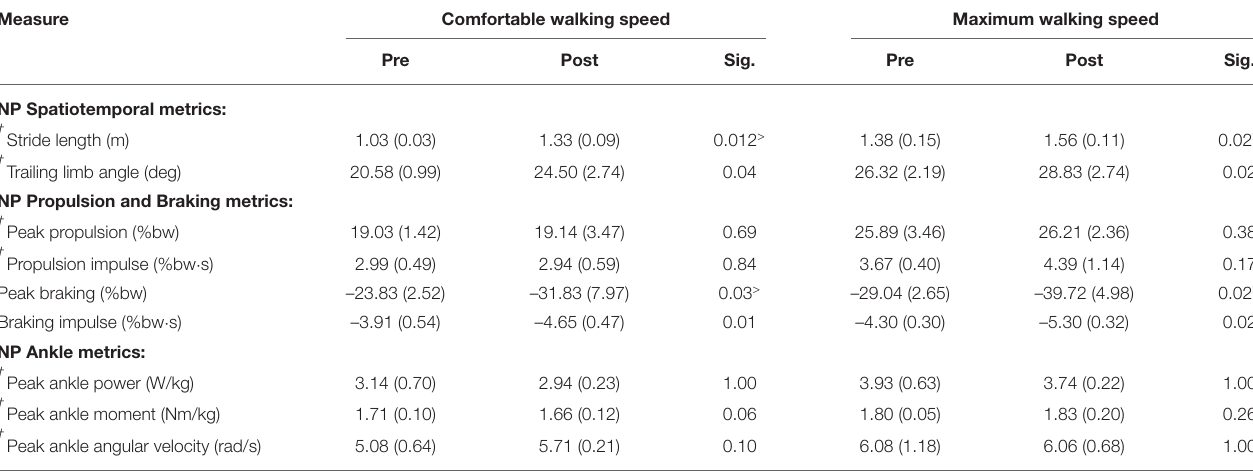
TABLE A1 | Biomechanical effects of REAL training, Pre- and post-training median (interquartile range) and p- values for non-paretic limb biomechanical parameters at comfortable and maximum walking speeds.